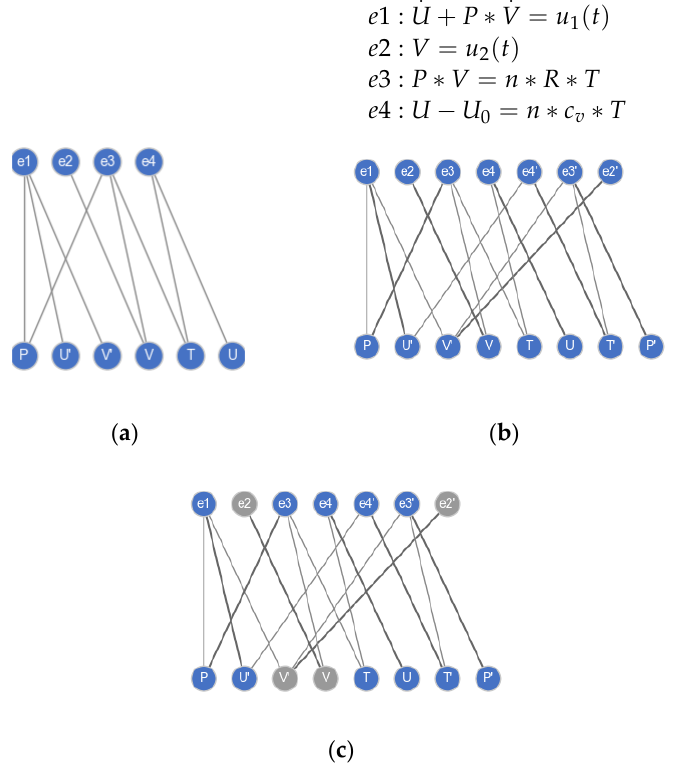
Figure 8. Decomposition of DAEs in the model of Equation (7). ( a ) Original bipartite graph. ( b ) Augmented bipartite graph. ( c ) Decomposition of the model.